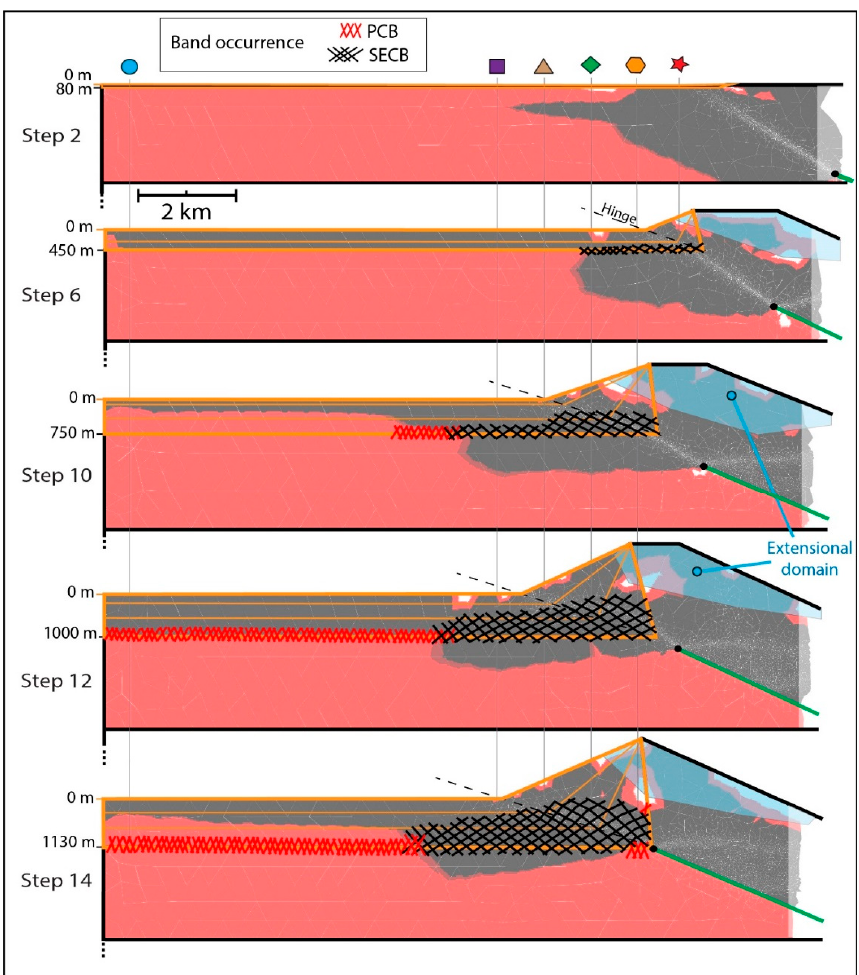
Figure 6. Deformation band distribution with the numerical stress results in comparison to the yield cap of the theoretical Aren calcarenite (P* = 30 MPa) for the steps 2, 6, 10, 12, and 14. Pure Compaction Bands (PCBs) are represented in red and Shear Enhanced Compaction Bands (SECBs) are represented in grey. The blue part on the top of the fold represents the extensional domain (maximum stress is sub-vertical). In the background, light red and grey colors represent the Q/P ratio obtained in Figure 4.